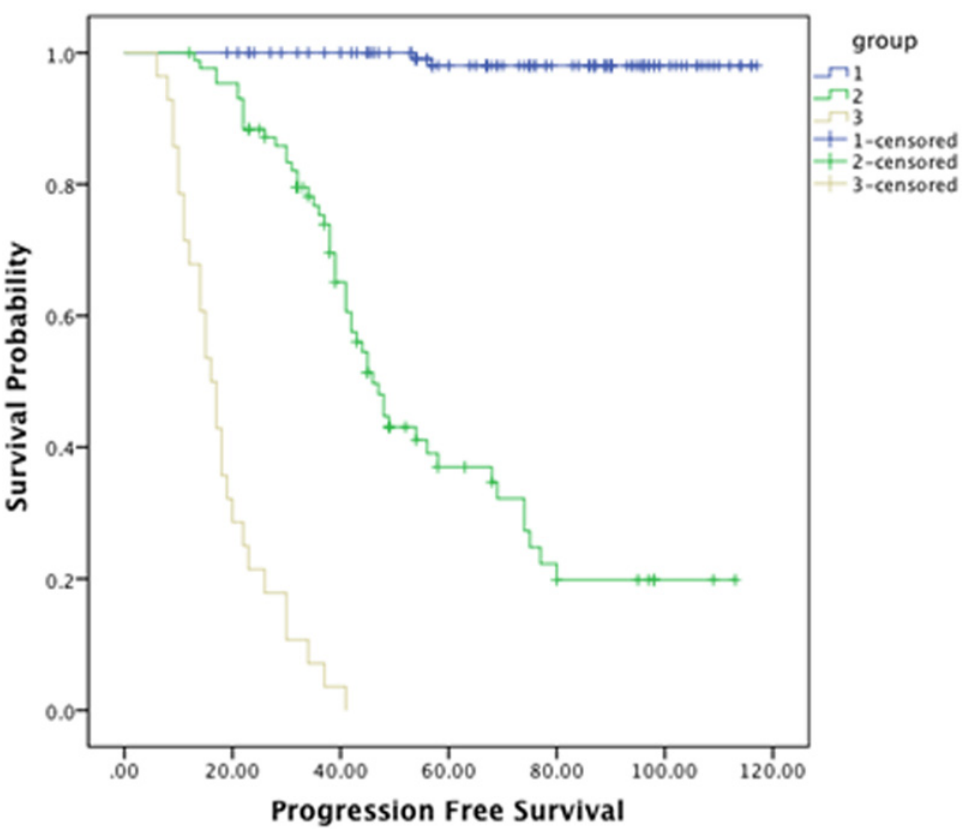
Fig 5. Progression free survival analysis among the groups I, II and III.